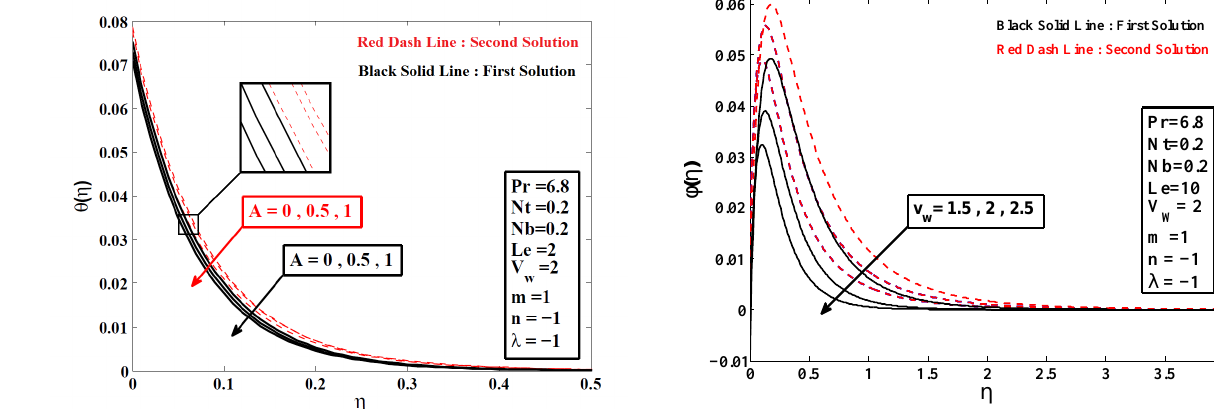
Figure 10: First and second solutions of temperature profile θ ( η ) for different values of unsteadiness parameter A .